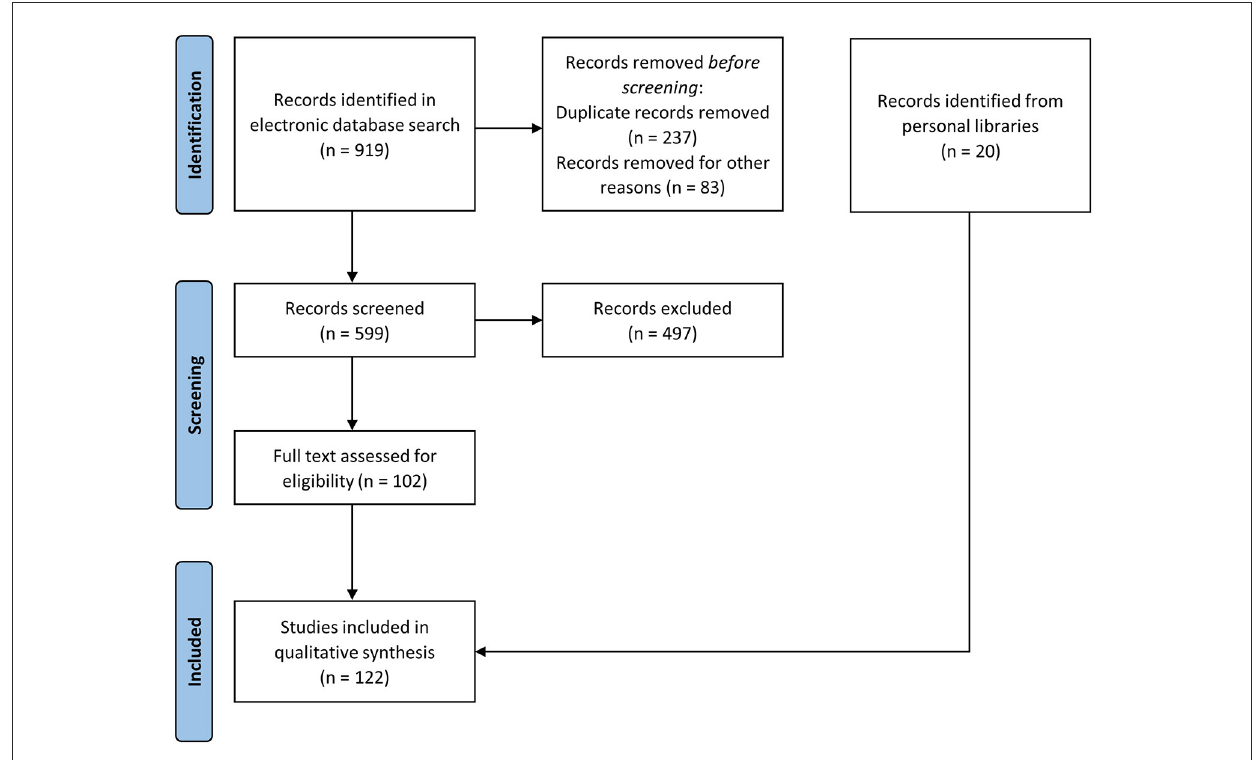
FIGURE1 PRISMA literature search